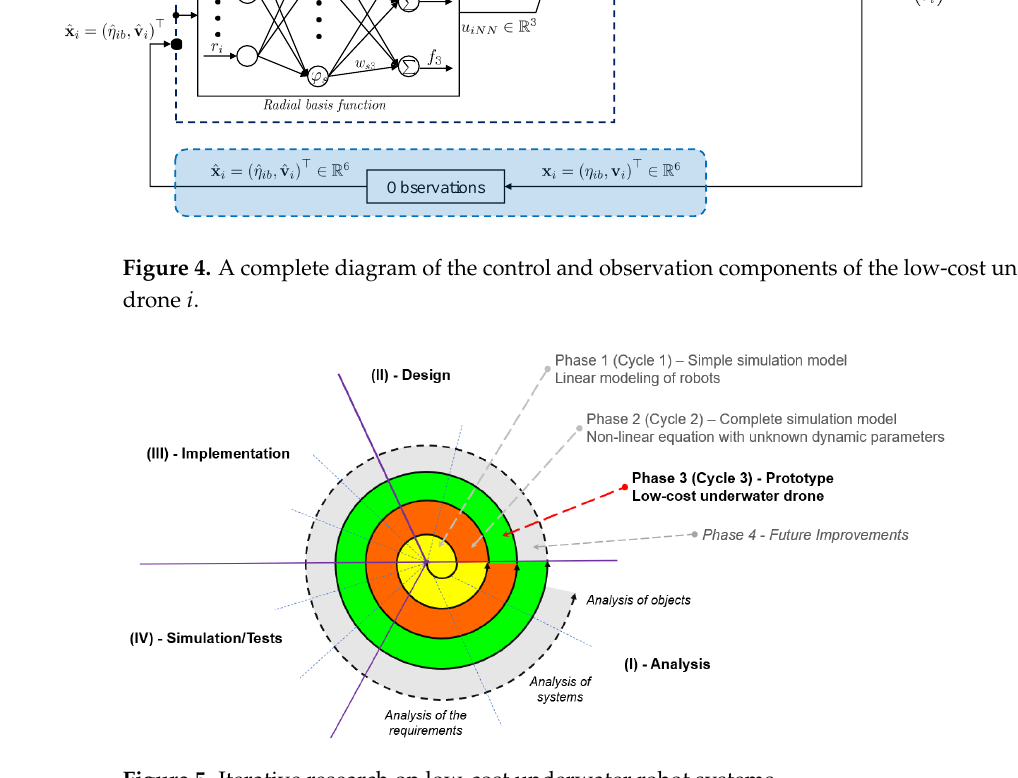
Figure 5. Iterative research on low-cost underwater robot systems.